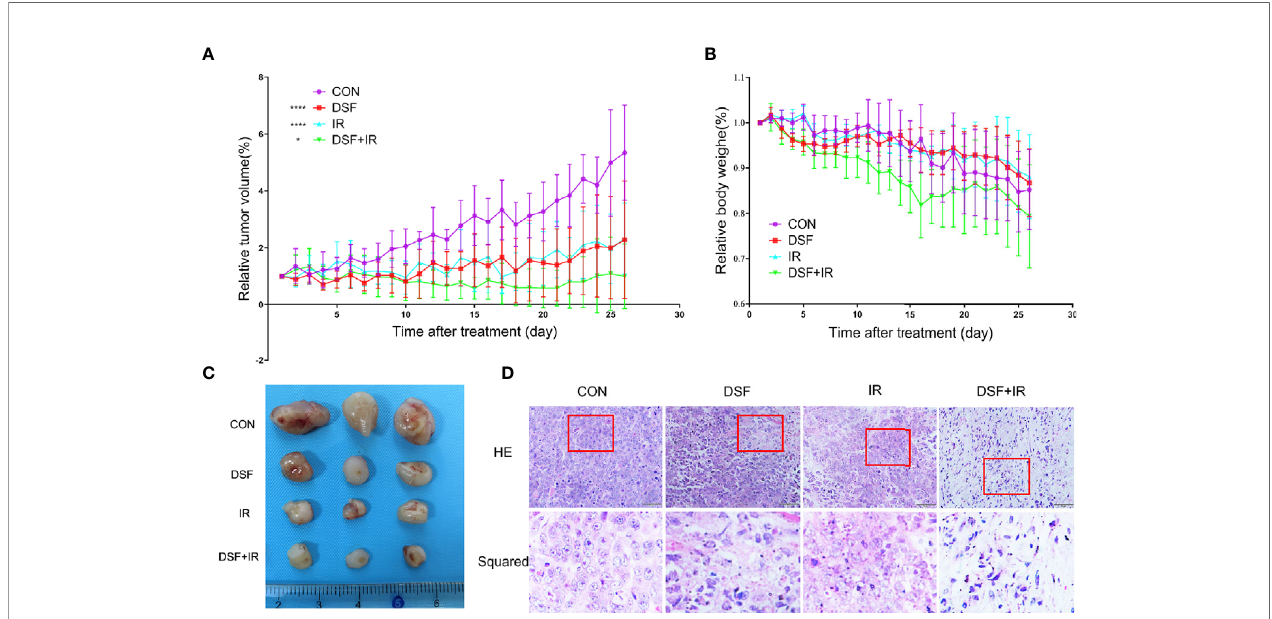
FIGURE 7 | DSF enhances the radiosensitivity of pancreatic cells in vivo . PANC-1 xenograft mice were divided into 4 groups (n=5): (1) intraperitoneal injection of vehicle (negative control); (2) intraperitoneal injection of DSF (75 mg/kg); (3) combination of vehicle and irradiation (5 Gy X-rays); and (4) combination of DSF and irradiation. (A) The tumor value was measured each day and calculated with the formula V=1/2ab 2 (a=length, b=width). *p < 0.05, ****p < 0.0001, using two-way ANOVA. (B) The weight of the mice was measured daily. (C) Visual observation of tumors in each group. (D) HE staining of tumor